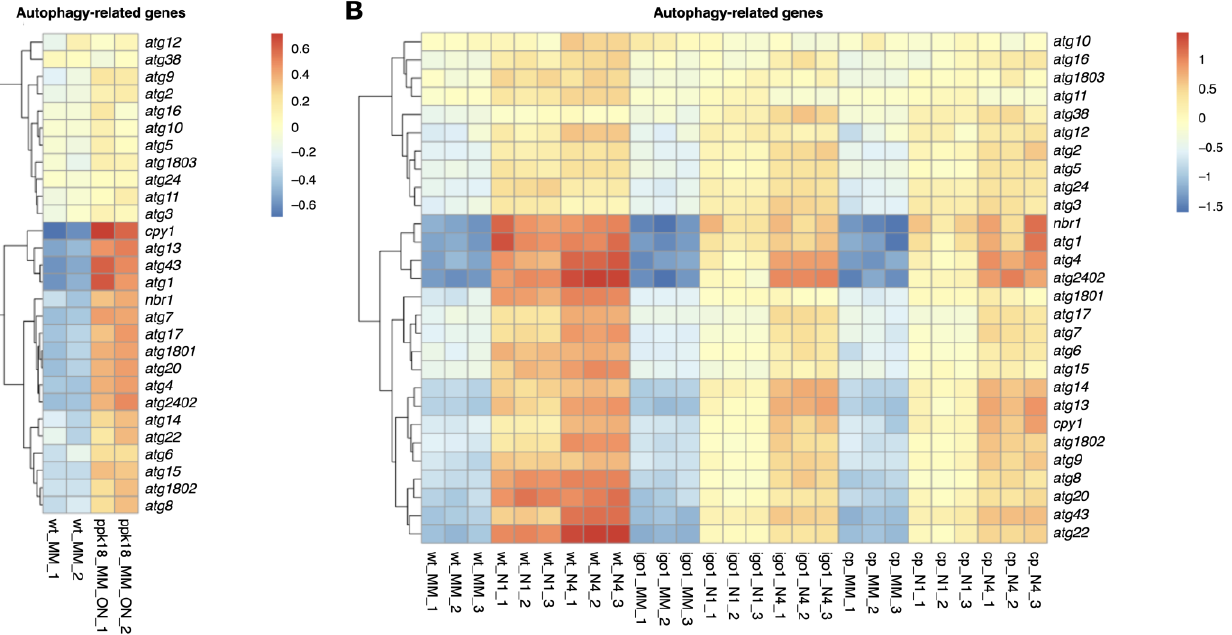
Figure 6. Heat maps of RNA-seq data showing autophagy-related genes induced by the Greatwall– Endosulfine switch. ( A ) Heat map showing autophagy-related genes upregulated by RNAseq after 20 h of Greatwall overexpression ( nmt1:ppk18 + ) in minimal medium compared to the wild type. Two independent experimental replicates are shown. ( B ) Autophagy-related genes induced by nitrogen starvation in wild type (wt), igo1 ∆ (igo1), and cek1 ∆ ppk18 ∆ (cp) in MM, MM-N 1 h (N1), and MM-N 4 h (N4). Three independent experimental replicates are shown.